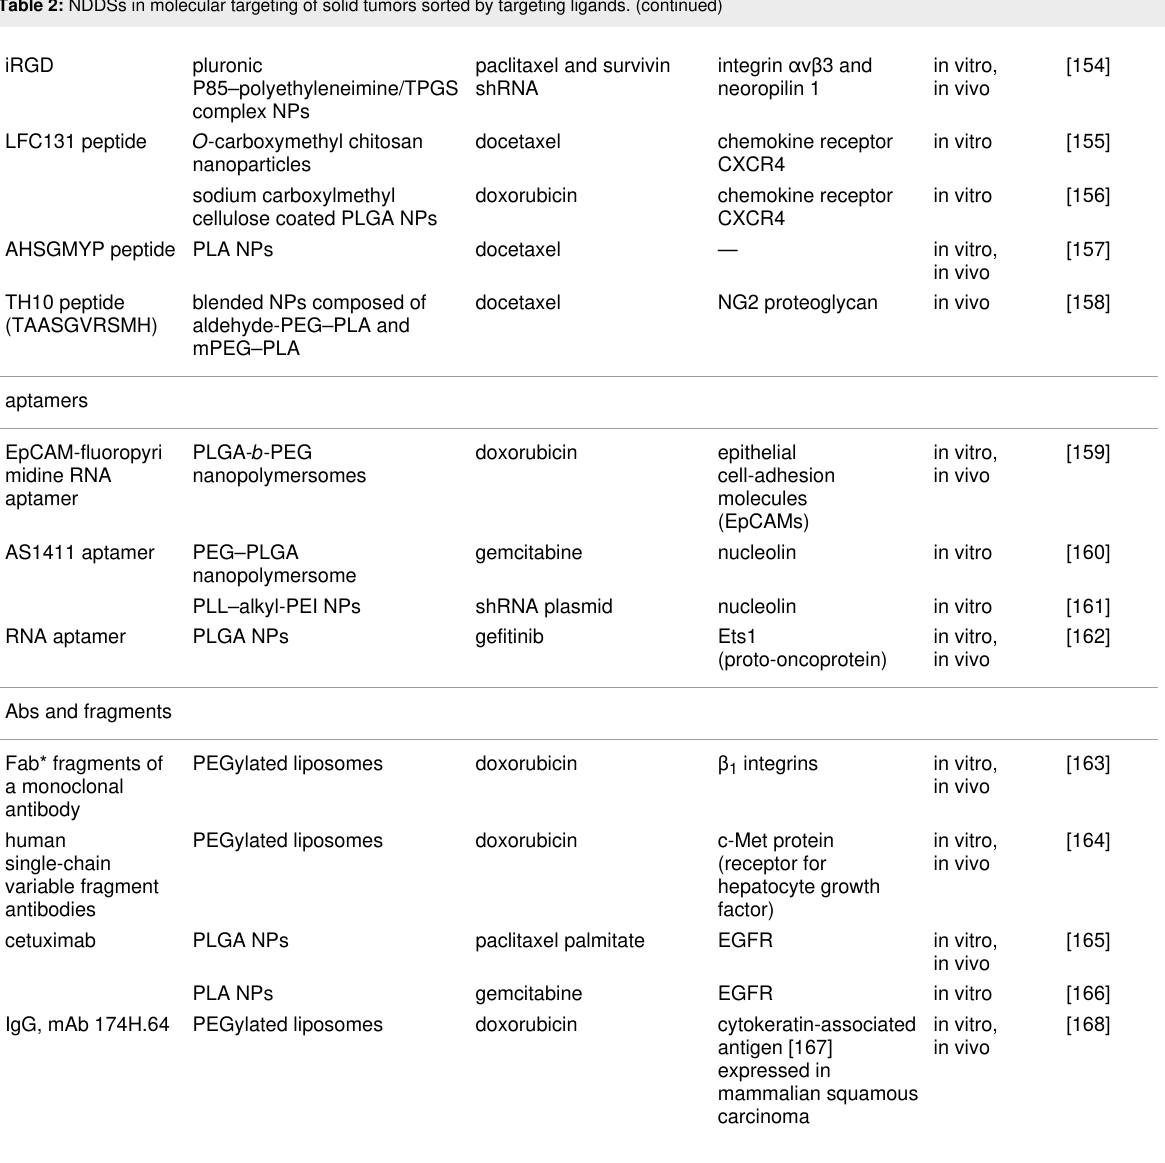
Table 2: NDDSs in molecular targeting of solid tumors sorted by targeting ligands. (continued)